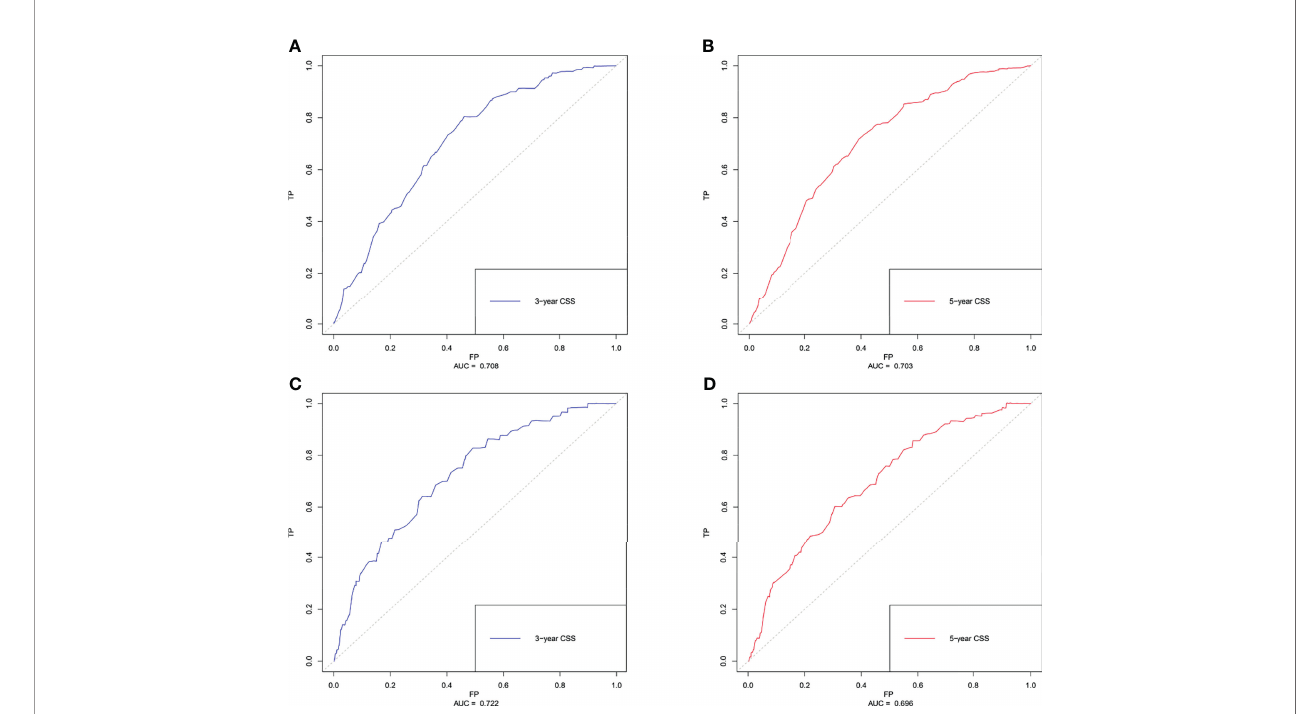
FIGURE 4 | The receiver operating characteristics (ROC) curve and area under the ROC curve (AUC). (A) predicting 3- year CSS in the training cohort; (B) predicting 5- year CSS in the training cohort. (C) predicting 3- year CSS in the validating cohort. (D) predicting 5- year CSS in the validating cohort. CSS, cancer-speci fi c survival.